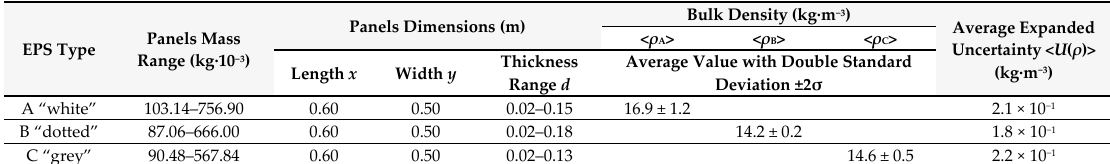
Figure 3. The measured bulk density ρ versus the panel thickness d for the EPS A, B, and C products. The error bars correspond to the expanded uncertainties, U ( ρ ). The horizontal arrows indicate the levels of the average density < ρ > values (see Table 2). Table 2. Data concerning density measurements of the materials expanded polystyrene (EPS) A, B, and C.